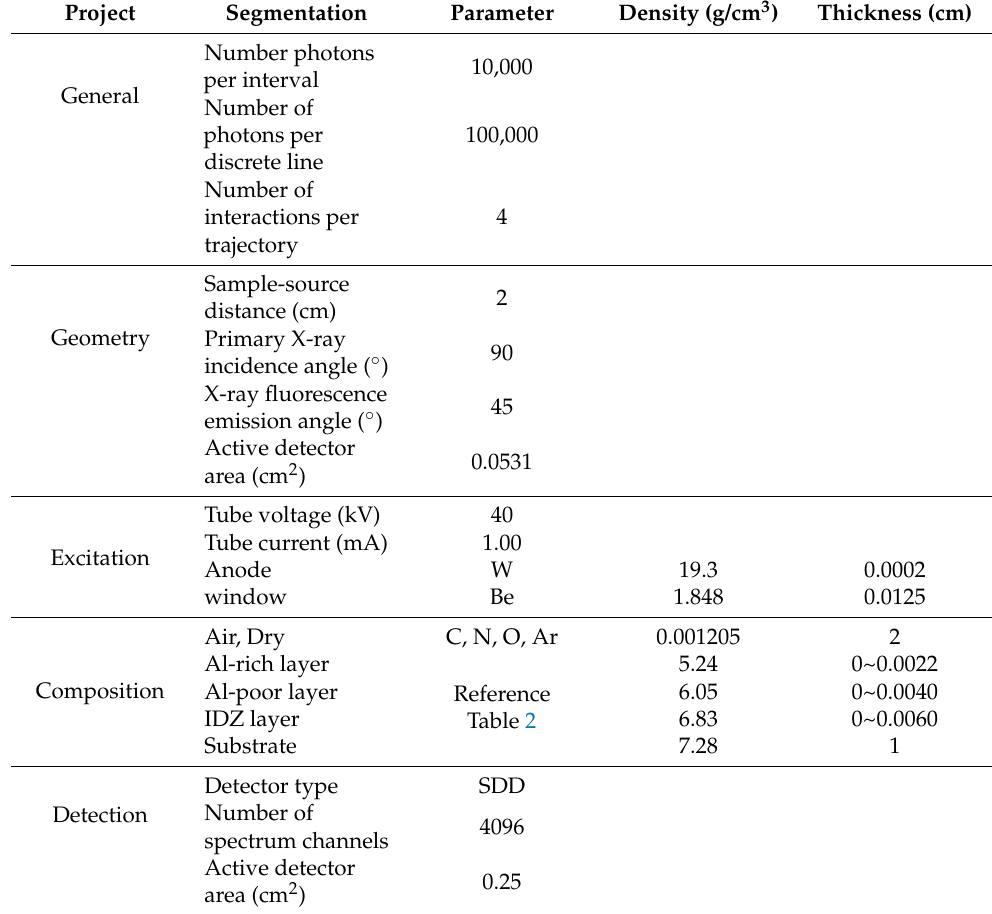
Table 1. Parameters for Monte Carlo simulation.